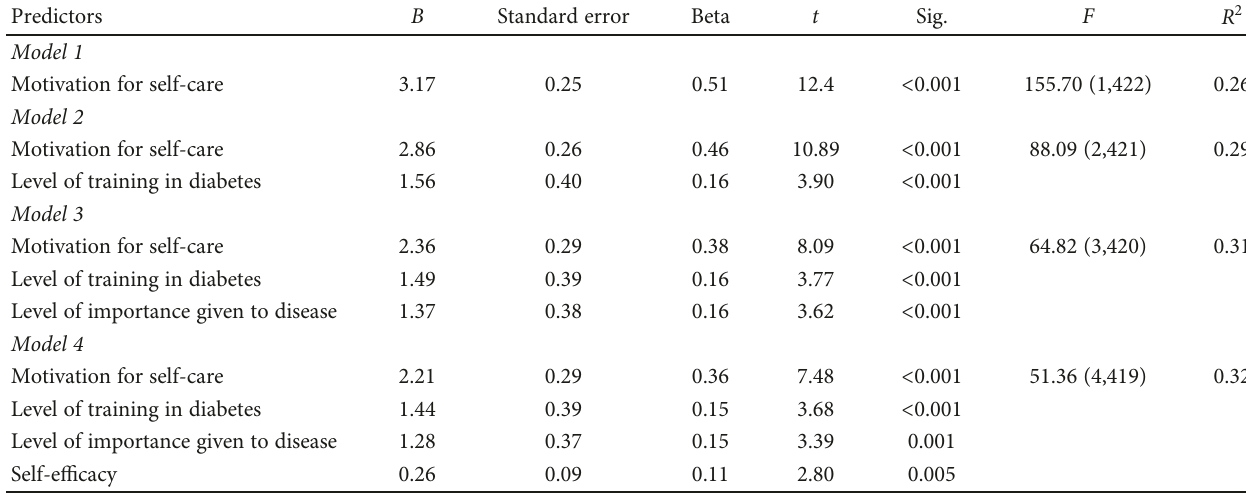
Table 3: Stepwise multiple linear regression analysis with dependent variable self-care (SCI-R) and the independent variables ( N = 428 ). Predictors